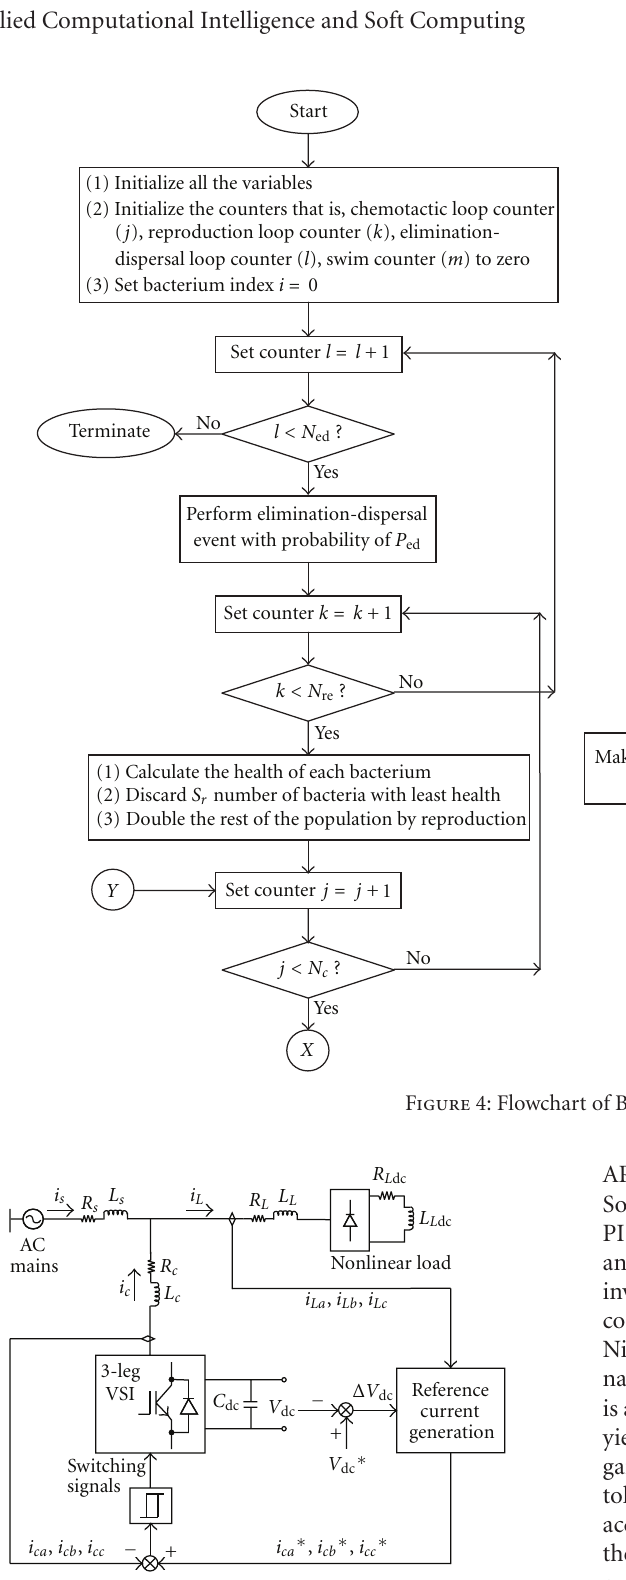
Figure 5: System configuration for 3-phase 3-wire shunt APF along with the nonlinear